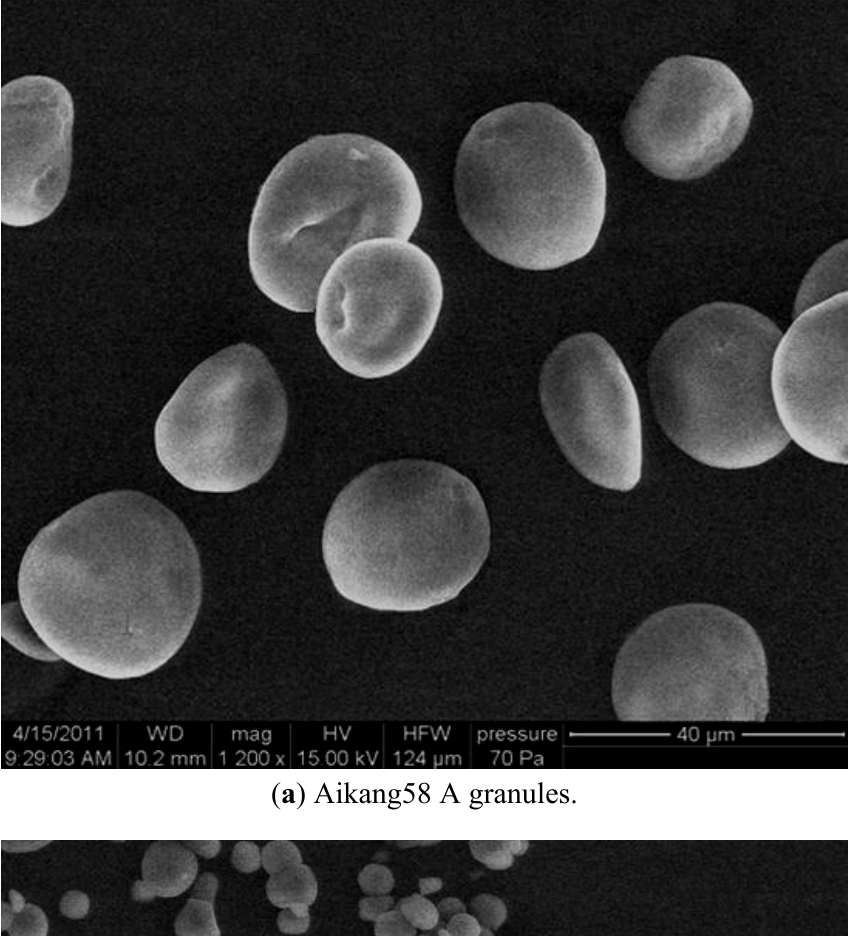
Figure 1. Scanning electron microscope images of unfractionated starch and isolated A- and B-granules